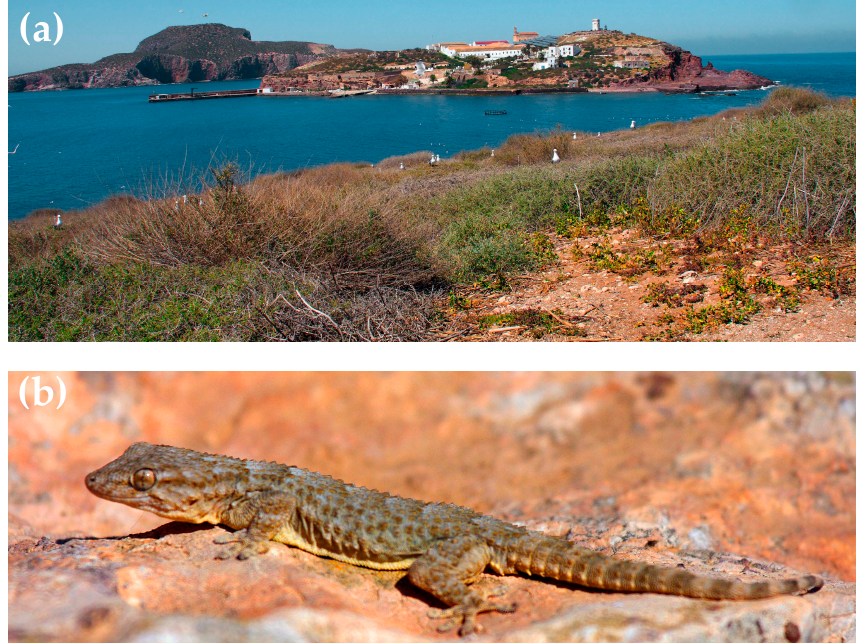
Figure 1. ( a ) Typical natural habitat at the Chafarinas Islands, with the uninhabited Rey Island in the foreground; the human-inhabited Isabel Island behind it in the middle, showing an apparently similar, but altered, seminatural habitat scattered between the buildings; and the Congreso Island in the background; ( b ) an adult T. mauritanica gecko on a rock in its natural habitat.